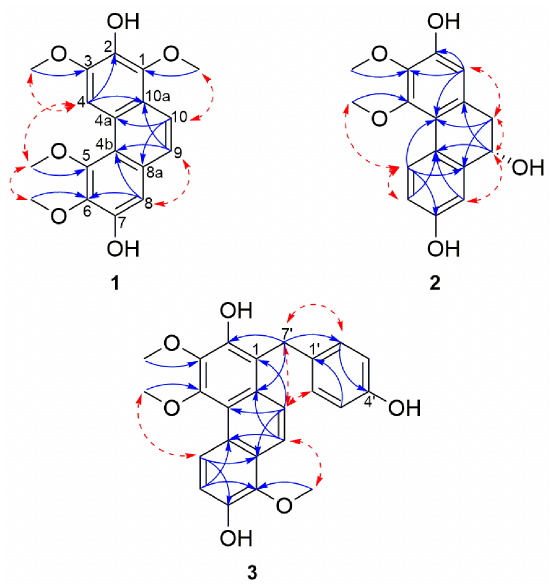
Figure 2. Selected NOESY (red dashed arrows) and HMBC (blue arrows) correlations of compounds 1 – 3 . Compound 4 was obtained as a pale yellow amorphous powder. The HRESIMS showed a [M + H] + molecular ion peak at m / z 511.1742 indicating a molecular formula of C 31 H 26 O 7 (calcd. C 31 H 27 O 7 for 511.1751) which is consistent with nineteen degrees of unsaturation. Its UV spectrum showed